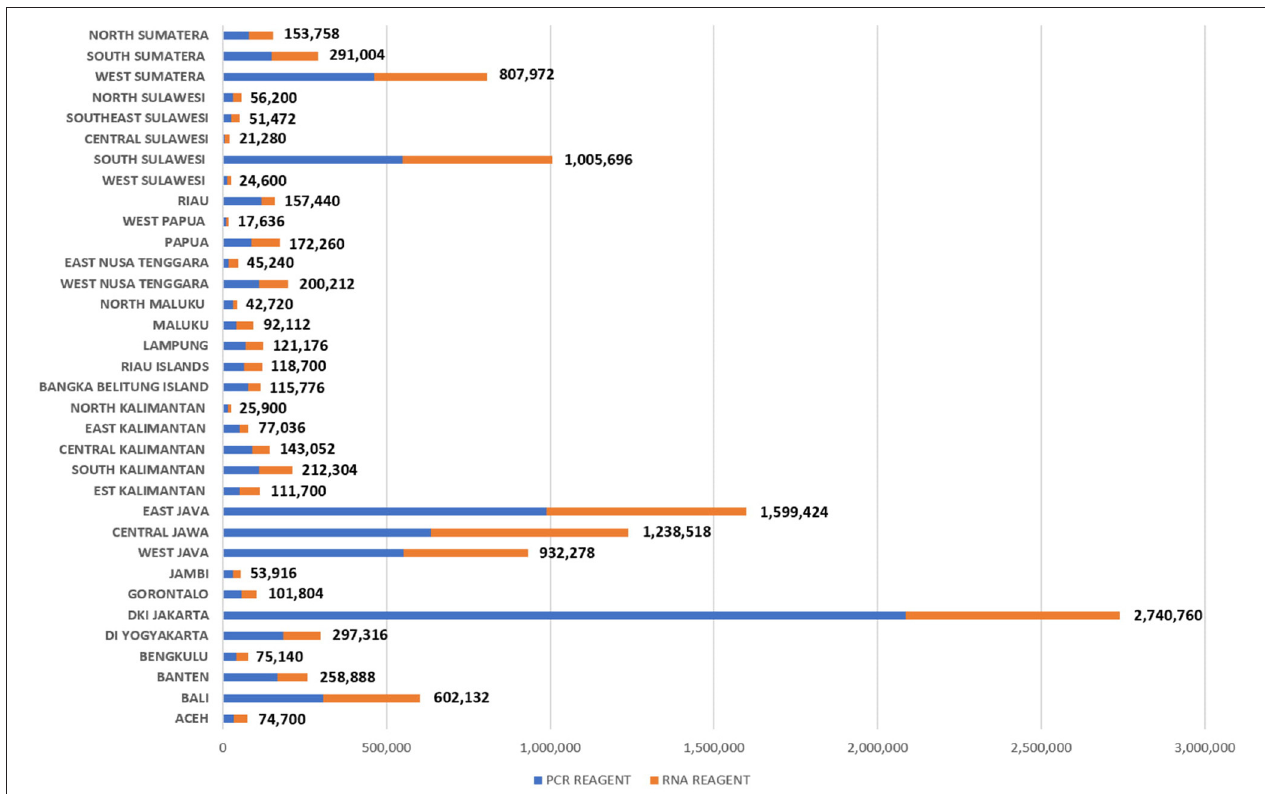
FIGURE 1 | Distribution of PCR and RNA reagents in Indonesia as per March 6th, 2021 (21).